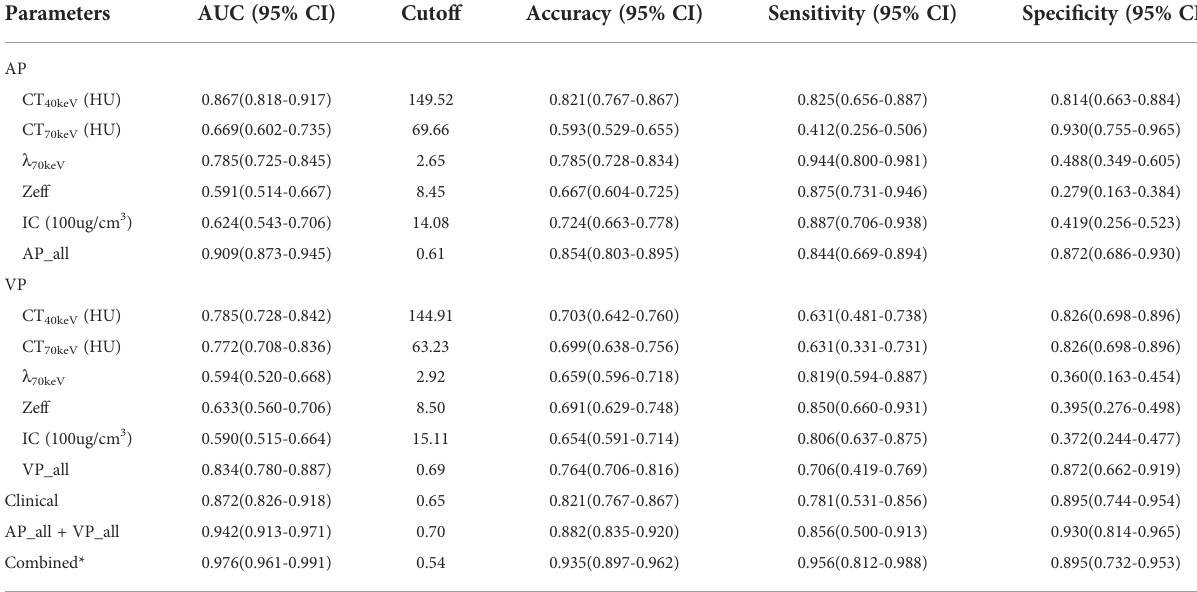
TABLE 3 ROC curve analysis of spectral CT parameters in distinguishing between SP-TB and S-LUAD. Parameters